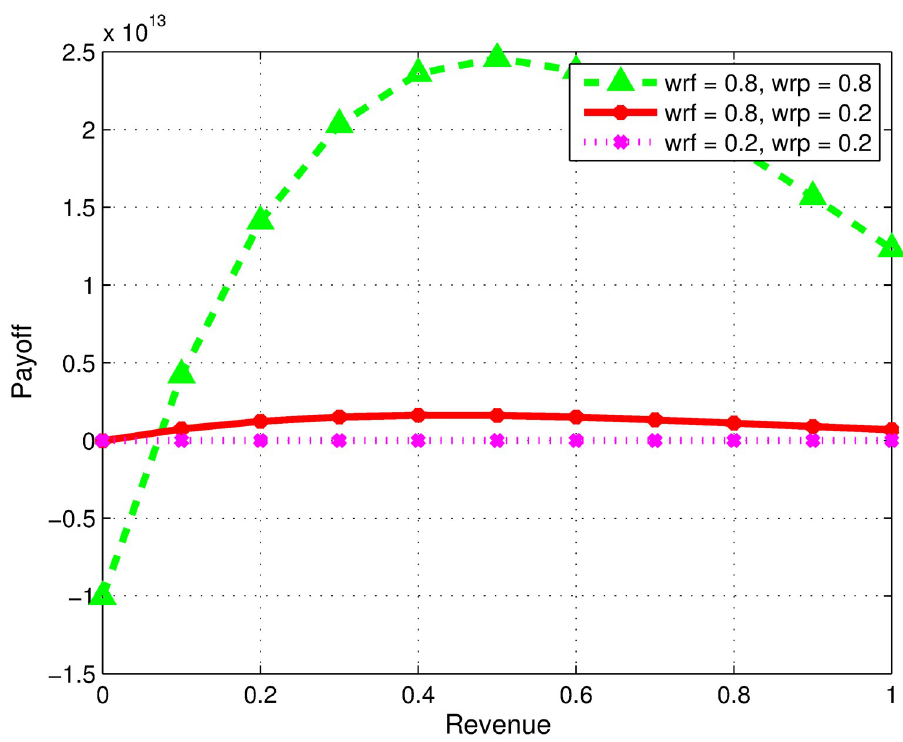
Fig 6. Impact of varying